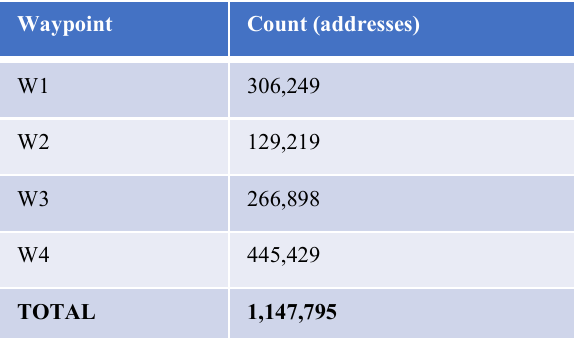
Table 4. The number of addresses routed to each waypoint, and the total number of